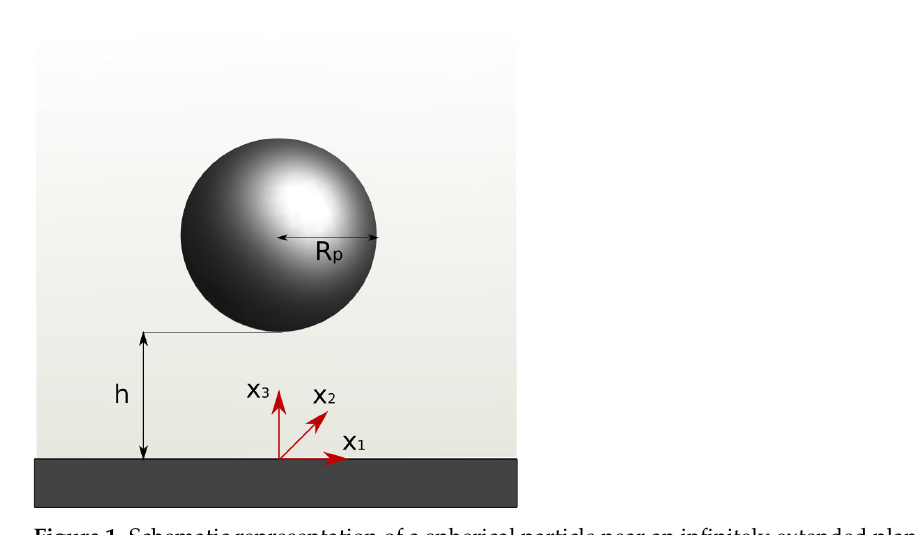
Figure 1. Schematic representation of a spherical particle near an infinitely extended planar